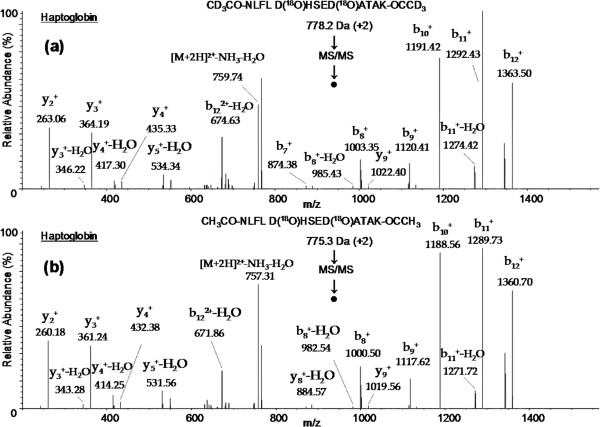
Tandem mass spectra of doubly charged ions of heavy CD3CO- NLFL D(18O)HSED(18O)ATAK- COCD3and light CH3CO- NLFL D(18O)HSED(18O)ATAK- OCCH3peptides as identified by LTL quantitative proteomics in normal and ovarian cancer sera analysis.